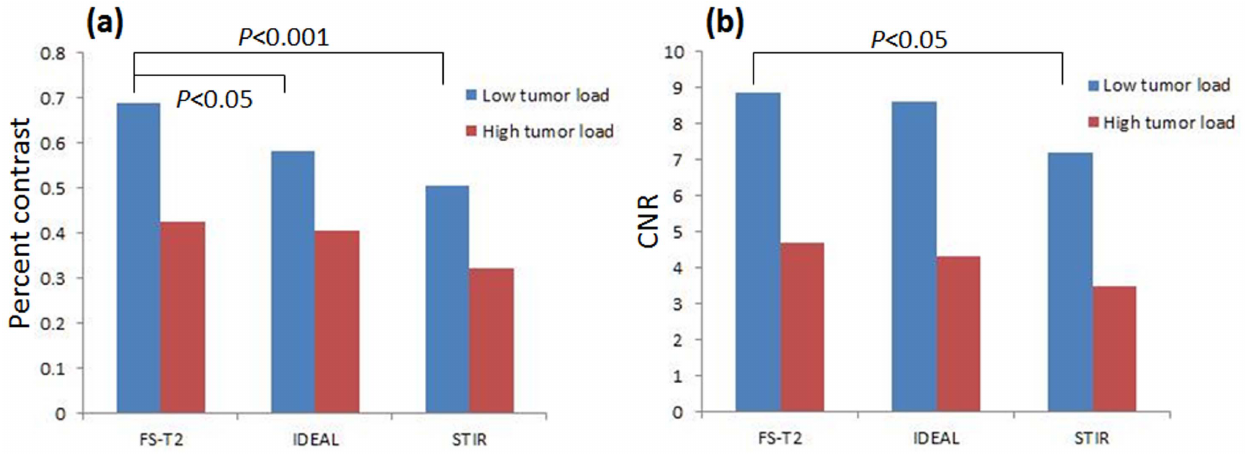
Figure 2. Percent contrast and CNR comparison among the three different fat-suppression sequences. BM-focal lesion percent contrast (a) and CNR (b) are significantly greater for FS-T2 FSE than for STIR in the low tumor load BM groups (P , 0.001, P , 0.05, respectively). In the low tumor load BM group, percent contrast is significantly higher for FS-T2 FSE than for water image of IDEAL (p , 0.05). doi:10.1371/journal.pone.0085931.g002 PLOS ONE |